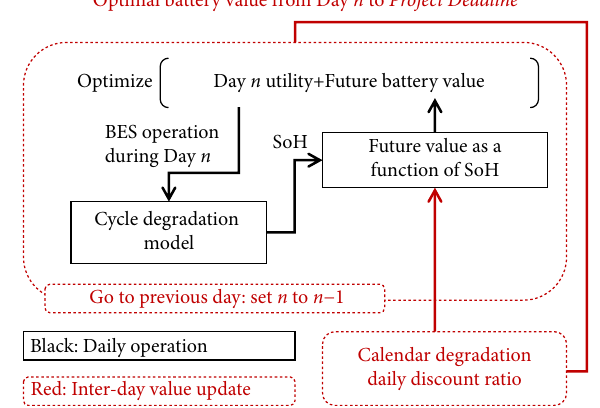
Fig. 2 The dynamic battery valuation framework. This framework works backward and keeps updating a value function to battery SoH. This function represents the value of the remaining battery SoH from the end of the current operating day till the project deadline, at which the battery has no more arbitrage value. On each operating day, the battery is optimized according to daily revenue income and the change in the battery SoH, based on a cycle degradation model. The result of this optimization is assembled into the new battery future value function, and this framework works recursively backward to evaluate the battery lifetime across the entire project